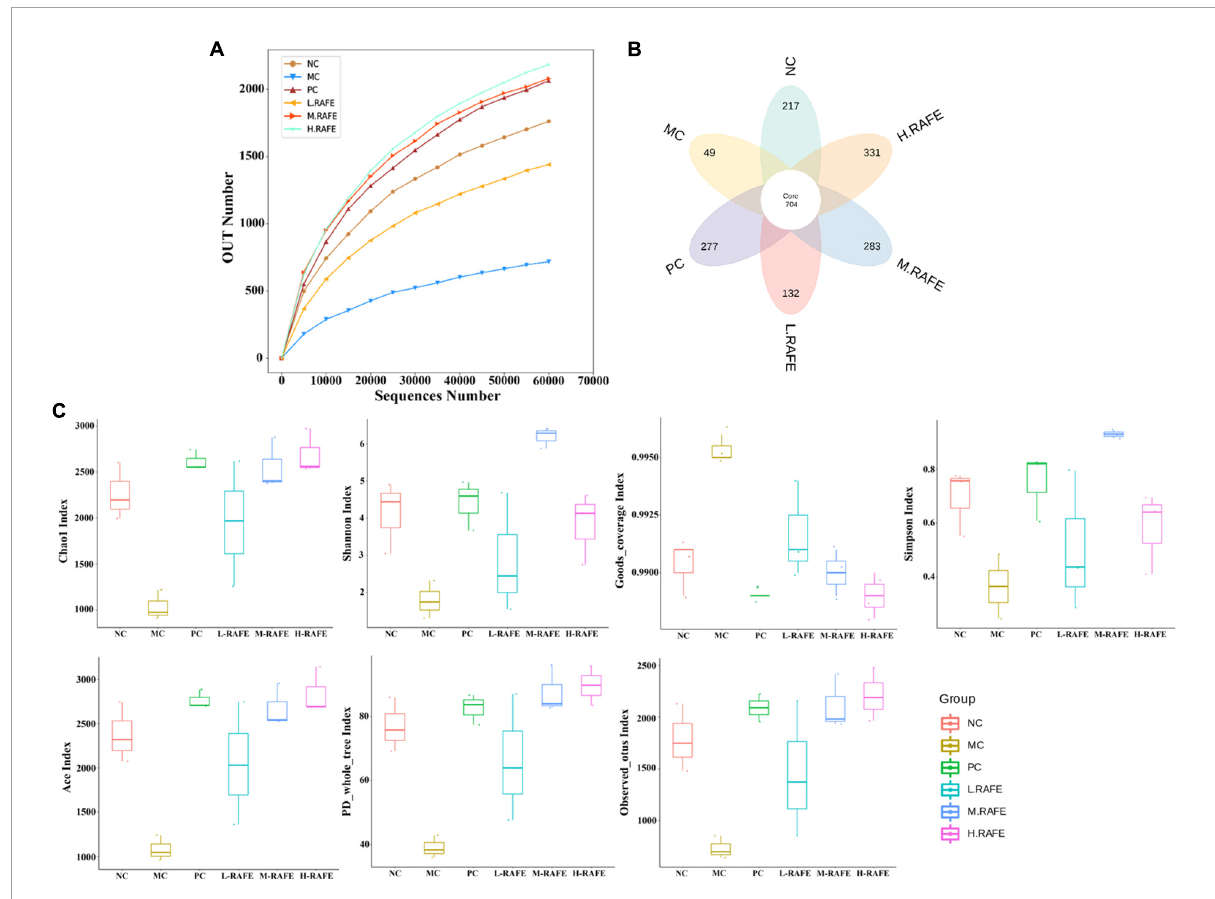
FIGURE6 Effect of RAFE on OTUs and alpha diversity of mice intestinal microorganisms. (A) Grouped dilution curves, where a flatter curve indicates a more uniform species distribution, (B) petal plot, and (C) alpha diversity analysis (Chao1, Shannon, Goods, Simpson, Ace, PD, and observed). n = 3